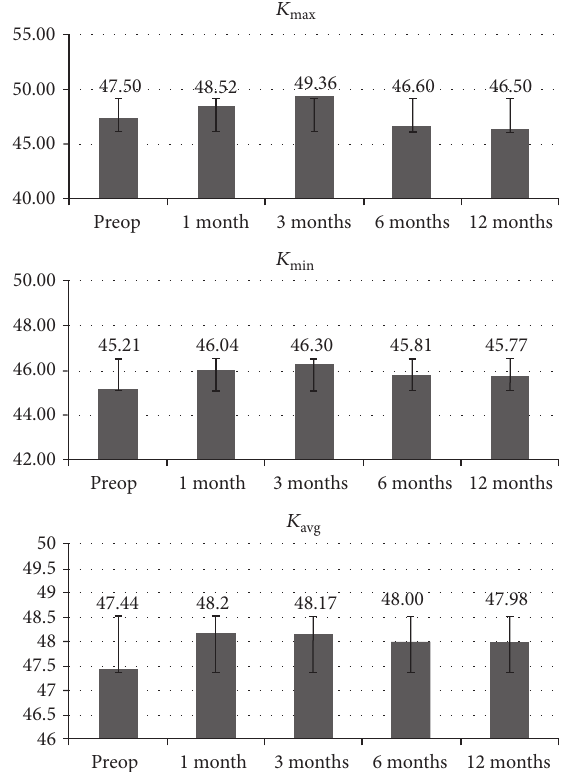
Figure 2: 𝐾 max , 𝐾 min , and 𝐾 after high-irradiance topography- average guided CXL. 1-year follow-up of simulated K readings tangential algorithm values data showed that 𝐾 max changed from 47.50±1.14 D to 46.50±1.81 D (𝑝 > 0.05) , while 𝐾 min value increased from 45.21± 0.67 D to 47.7 ± 0.91 D (𝑝 < 0.05) . 𝐾 values passed from average 47.44 ± 0.99 D to 47.98 ± 1.42 D (𝑝 > 0.05) . Figure 3: Coma, RMS, and spherical aberration values after high- irradiance topography-guided CXL. 1-year follow-up aberrometry data showed a statistically significant coma value reduction (𝑝 < 0.05) .NostatisticallysignificantchangeswererecordedforRMSand spherical